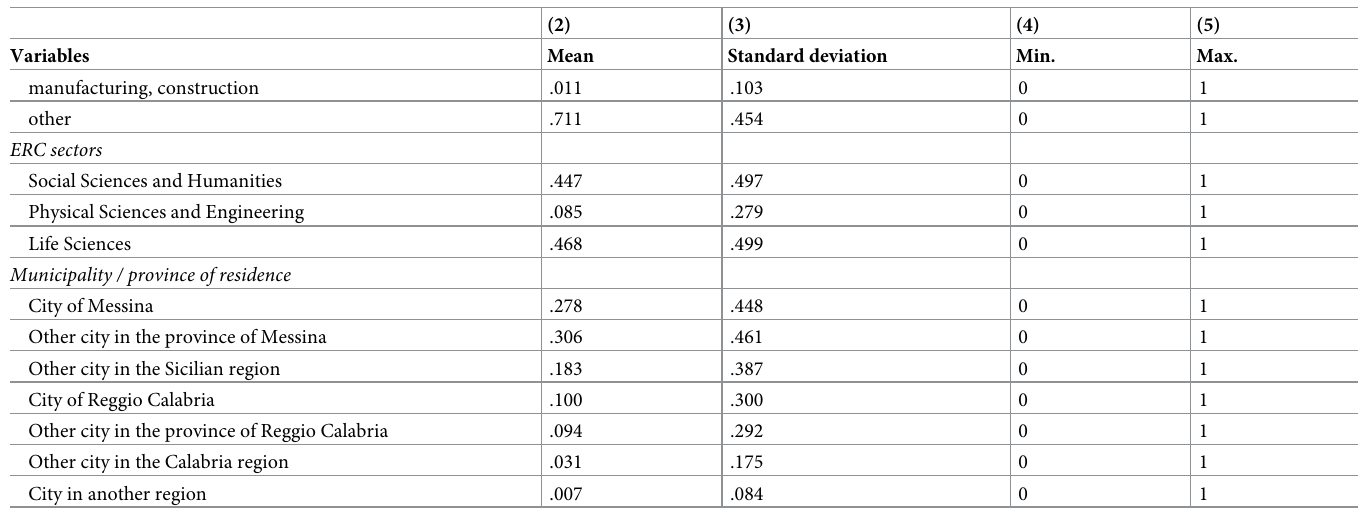
Five density distribution by gender is also graphically presented in Fig 1. With respect to men, women score higher on agreeableness and conscientiousness but lower on extraversion and emotional stability. However, the effect sizes (Cohen’s d ) for such scales are low (mean abso- lute value d = .166) except for emotional stability ( d = 0.602). The latter result is consistent with the findings from psychological literature that women are more inclined to experience anxiety and internal distress than men since the early stages of adolescence [63]. The results are available in S1 Table 2 in S1 Appendix.